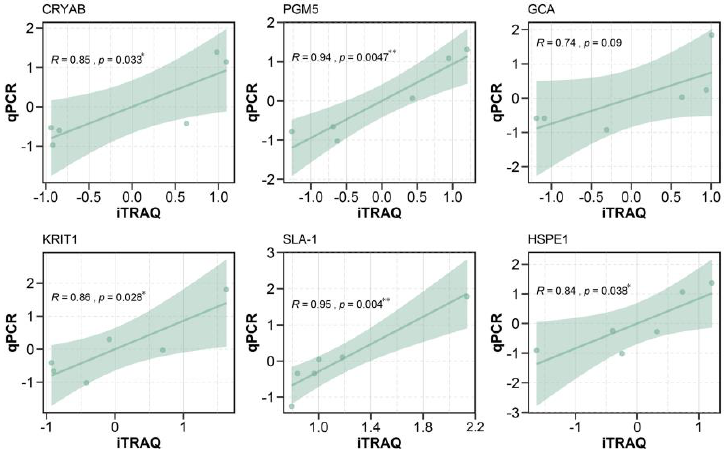
Figure 6. Correlation analysis between RT-qPCR results and iTRAQ. Results of correlation analysis between CRYAB , PGM5 , GCA , KRIT1 , SLA-1, and HSPE1 gene expression and iTRAQ. The X-axis indicates a normalized fold change of protein in sequencing. The Y-axis indicates a normalized fold change of